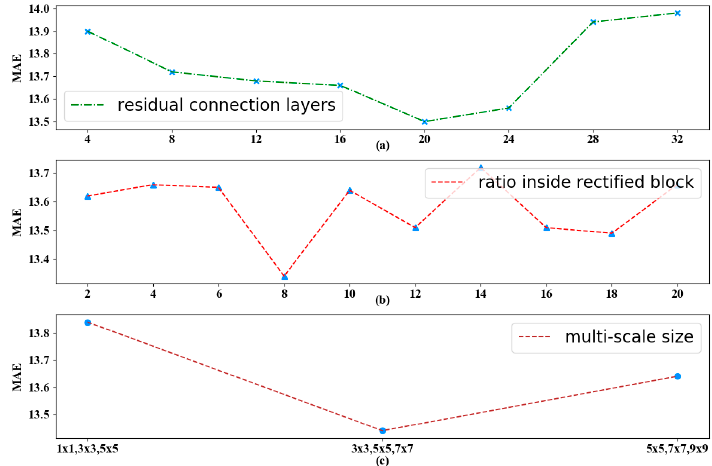
Figure 8. The tuning process for the key hyper-parameters inside our model. In detail, the ratio stands for temporal modeling and reception field size suggests reasonable spatial dependencies, while the residual connection layers control the total depth for our network. ( a ). The influence of different residual connection layers on MAE. ( b ). The influence of different ratios inside rectified block on MAE. ( c ). The influence of different multi-scale sizes on MAE.